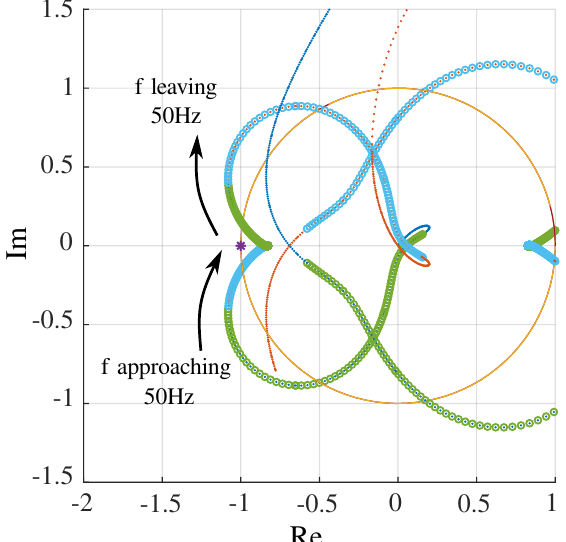
Figure 6. The eigenloci of the interconnected system of a GSC and a weak grid where SCR =